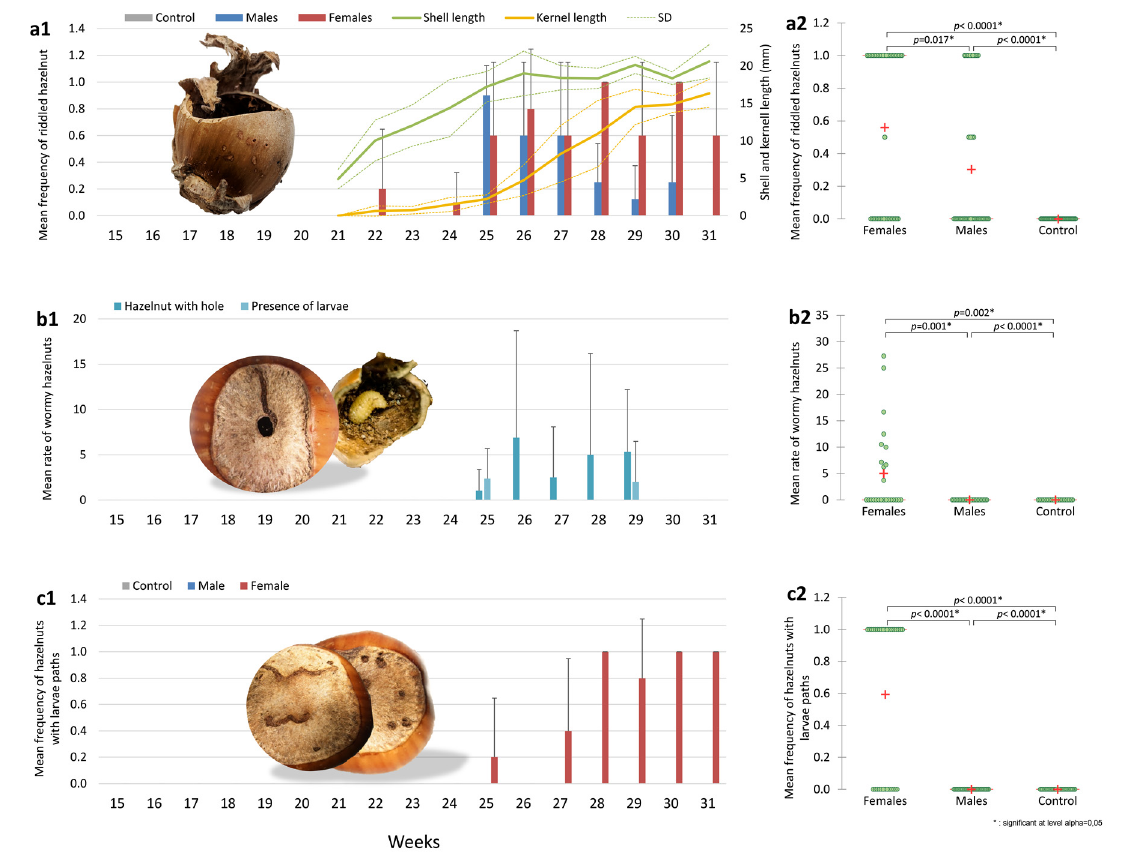
Figure 2. Exclusive damages observed per net sleeve based on stage of nut development and the presence of male or female hazelnut weevils: ( a1 ) mean number of riddled hazelnuts, according to nut development; ( a2 ) mean number of riddled hazelnuts during shell maturation (weeks 26 to 31); ( b1 ) mean number of wormy hazelnuts according to nut development; ( b2 ) mean number of wormy hazelnuts during kernel development (weeks 25 to 29); ( c1 ) mean number of hazelnuts showing larvae paths according to nut development; ( c2 ) mean number of hazelnuts showing larvae paths during kernel development (weeks 25 to